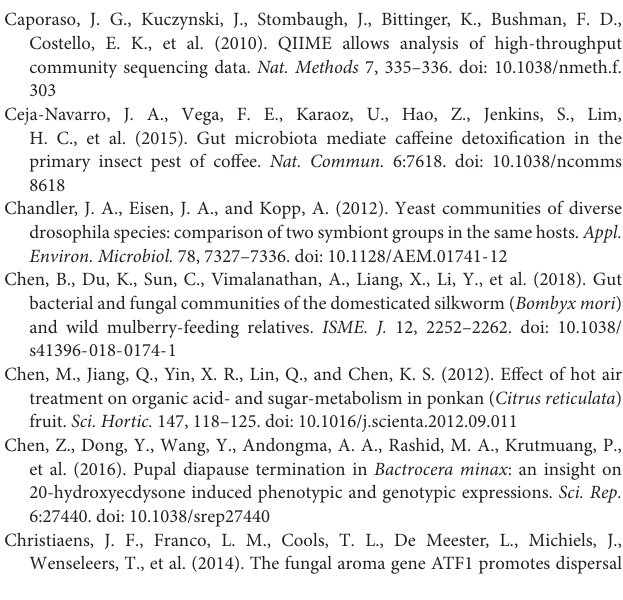
FIGURE S2 | Species accumulation and rank-abundance curves of fungus based on bacterial OTUs at a similarity level of 97%. (A) Species accumulation curves. (B) Rank-abundance curves. FIGURE S3 | Taxonomic compositions of microbiotas at the phylum level. (A) Bacterial composition of two field populations. (B) Fungal composition of two field populations. FIGURE S4 | Relative abundance of bacterial families across the lifespan of larvae. (A–K) Boxplots showing the mean abundance of bacteria in the larval gut. In every panel, the left side represents the population collected from ZG ( n = 4), and the right side represents the population collected from DJK ( n = 4). Multiple comparisons were performed in the two group separately. Different letters indicate a significant difference between different instars in each group ( p < 0.05, one-way ANOVA, Tukey post hoc test). The lines show median values per region window, and the shaded area denotes the estimated 95% confidence interval. FIGURE S5 | Relative abundance of fungi across the lifespan of larvae. (A–L) Boxplots showing the mean abundance of fungi in the larval gut. In every panel, the left side represents the population collected from ZG ( n = 4), and the right side represents the population collected from DJK ( n = 4). Multiple comparisons were performed in the two group separately. Different letters indicate a significant difference between different instars in each group ( p < 0.05, one-way ANOVA, Tukey post hoc test). The lines show median values per region window, and the shaded area denotes the estimated 95% confidence interval. FIGURE S6 | Predicted gut bacterial functions of larvae from two field populations. (A–J) the inferred metabolic pathways amino acid metabolism, energy metabolism, metabolism of cofactors and vitamins, xenobiotics biodegradation and metabolism, lipid metabolism, nucleotide metabolism, glycan biosynthesis and metabolism, enzyme families, metabolism of other amino acids and metabolism of terpenoids and polyketides are shown at the second hierarchical level ( n = 4). Multiple comparisons were performed in the two group separately. Different letters indicate a significant difference between different instars in each group ( p < 0.05, one-way ANOVA, Tukey post hoc test). TABLE S1 | Comparisons of the relative abundance of gut bacteria from larval and adult samples at family level. TABLE S2 | The nearest sequenced taxon index (NSTI) of larval samples. DATA SHEET S1 | The shared OTUs across the lifespan of larvae. DATA SHEET S2 | The relative abundance of KEGG pathways in larvae predicted by